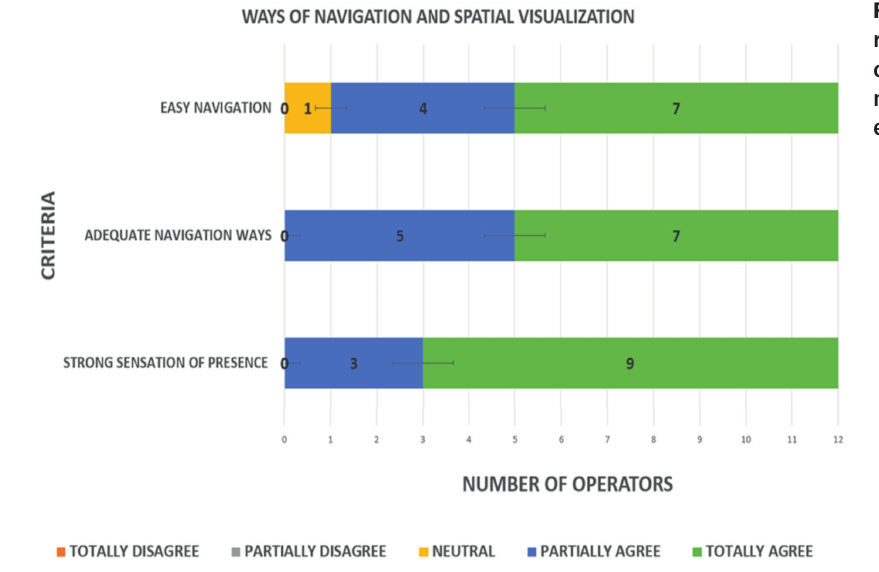
Figure 13. Graph regarding the activity “Locating and Approaching the Equipment”.